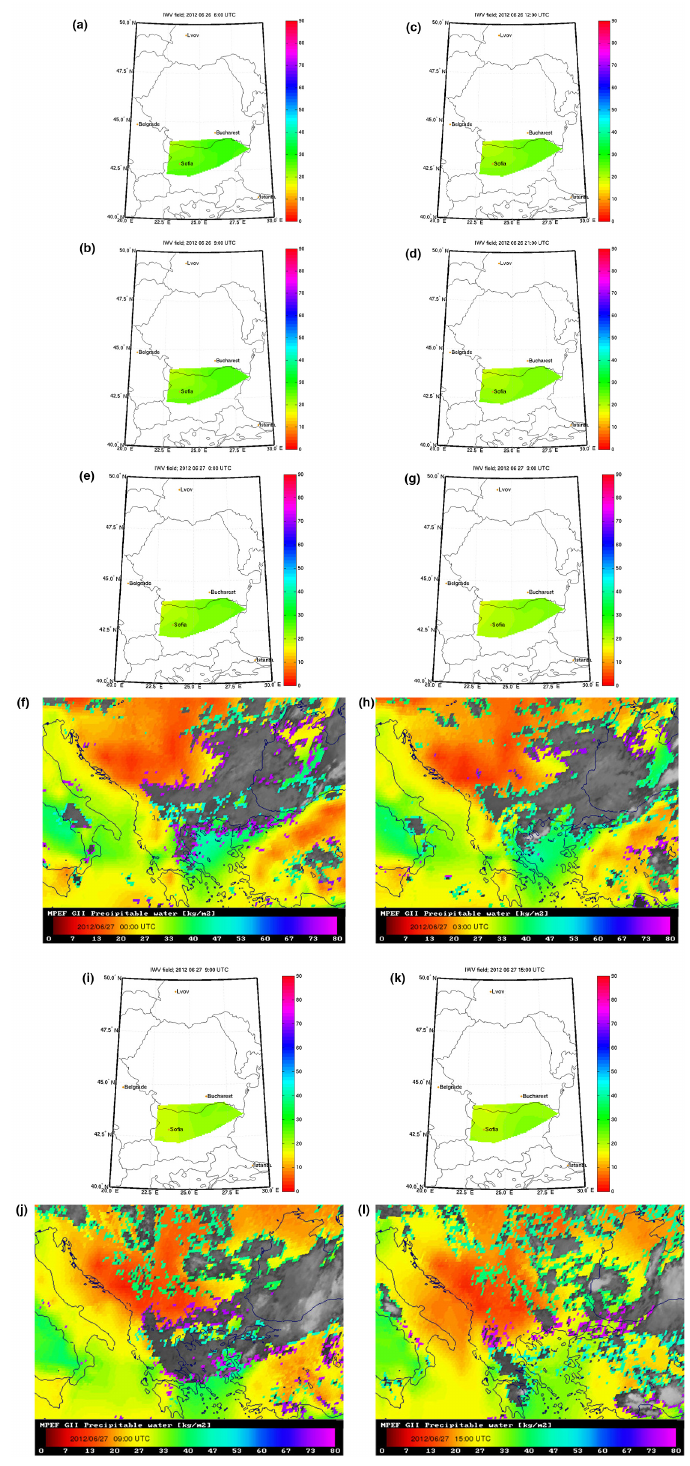
Figure 6. Two-dimensional IWV maps from GNSS on 26 June 2012 at (a) 06:00UTC, (b) 09:00UTC, (c) 12:00UTC and (d) 21:00UTC. Two-dimensional maps on 27 June 2012 at 00:00UTC: (e) GNSS and (f) Meteosat, 06:00UTC; (g) GNSS and (h) Meteosat, 09:00UTC; (i) GNSS and (j) Meteosat, 15:00UTC; (k) GNSS and (l) Meteosat. The colour maps of Meteosat and GNSS–IWV are